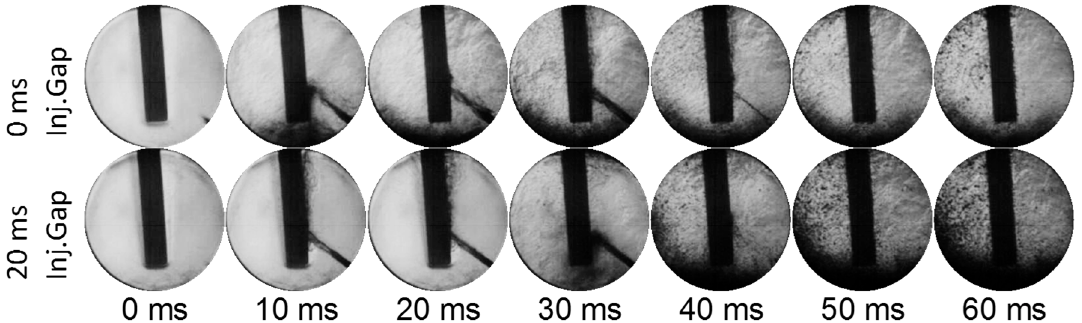
Figure 7. Mixture distribution for 0 ms and 20 ms injection gaps for 60/40 diesel/CNG composition.